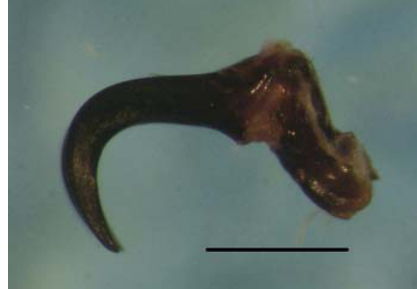
Image 14. Trichobothria on Tarsus III. Scale 1.0mm